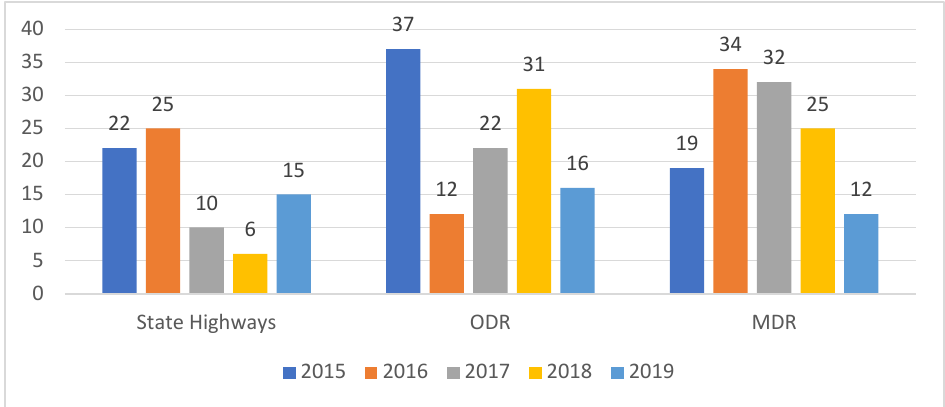
Figure 1. Delayed highway/road construction projects (Source: Information through RTI).